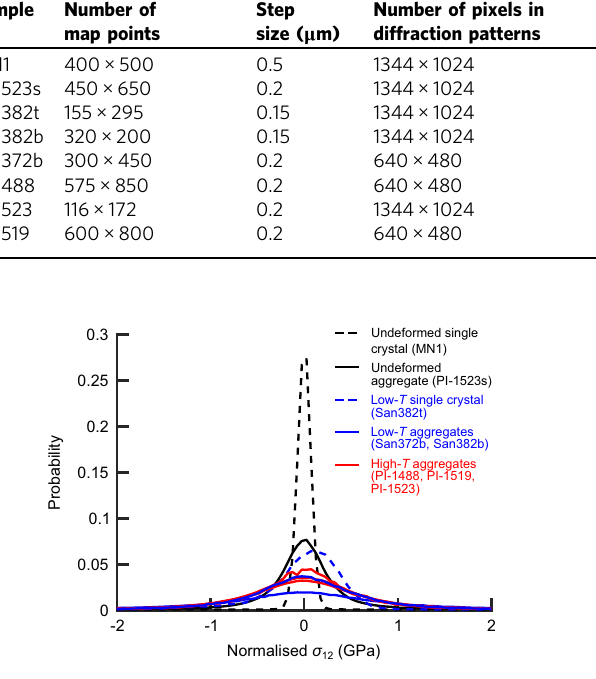
Fig. 2 Probability distributions of stress heterogeneity. Probabilities of stress heterogeneity, represented as normalised σ 12 , were calculated using bin widths of 50